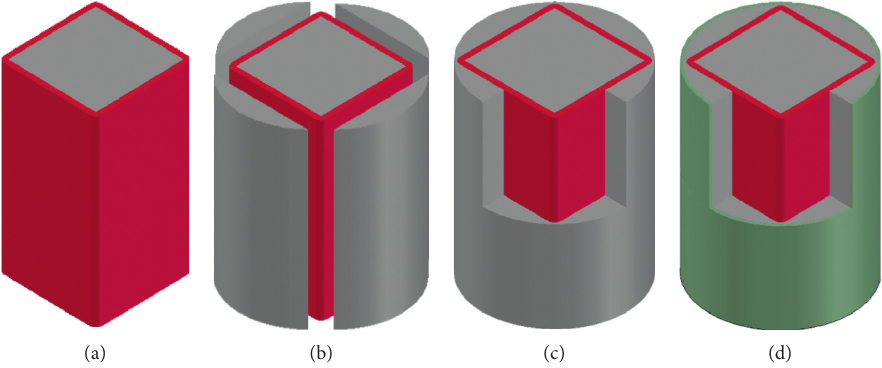
Figure 2: Production process of specimens. (a) CFSST column. (b) CAM bonding. (c) CAM fixing. (d) CFRP